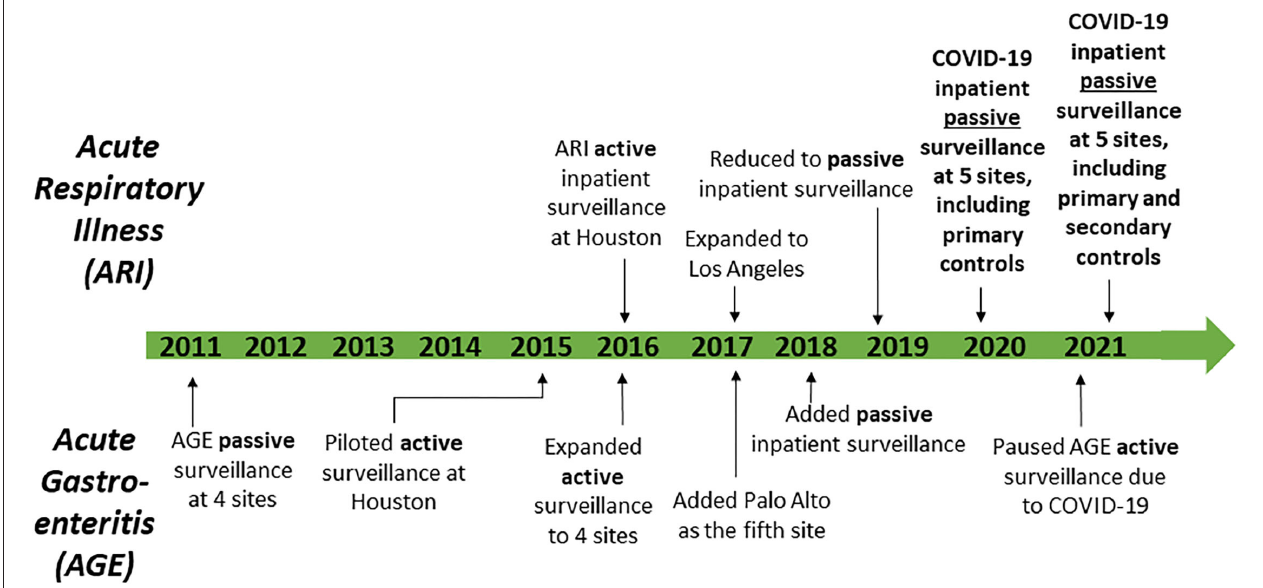
FIGURE 2 | Timeline of surveillance activities—Surveillance Platform for Enteric and Respiratory Infectious Organisms at Veterans Affairs Medical Centers (SUPERNOVA),